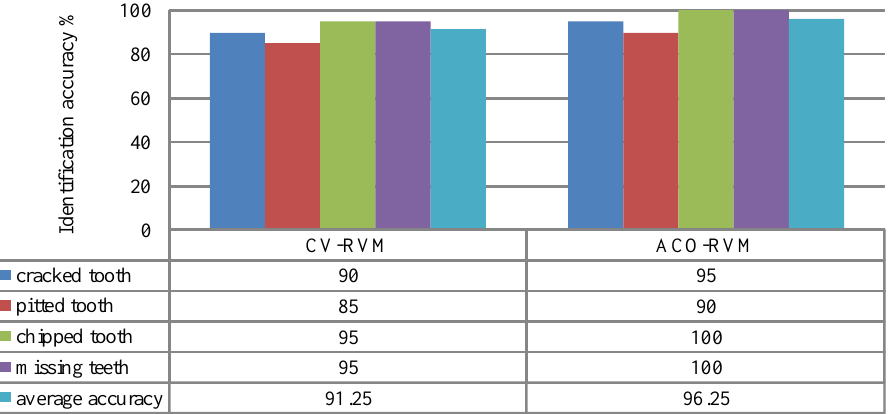
Figure 18. Comparisons of identification accuracy between the CV-RVM classifier and the ACO-RVM classifier in the planetary gearbox test. * The parameter  of the RVM based on the CV and the ACO are denoted by = 140.74 and = 2.15